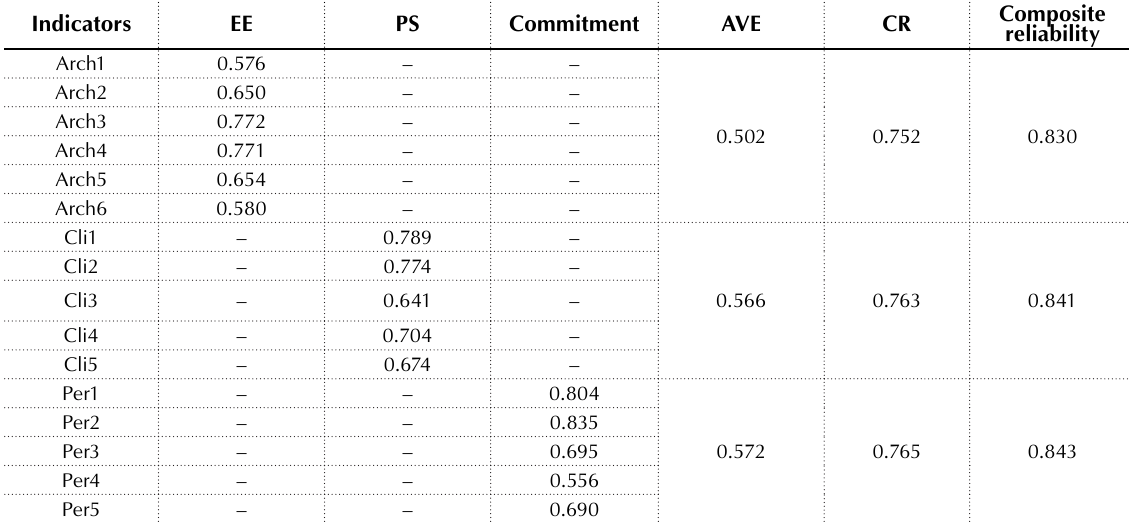
Table 4. Result of outer loading